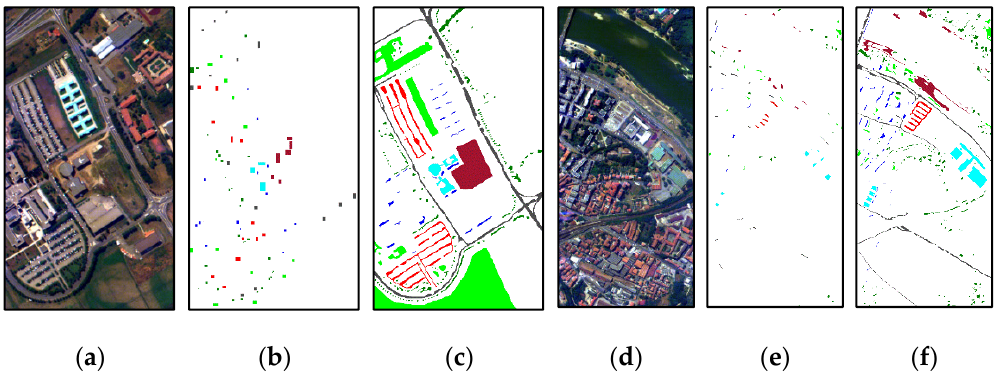
Figure 2. Color composite images of the ( a ) ROSIS Pavia University with the corresponding ground truths: ( b ) train map; ( c ) test map; ( d ) Pavia City Centre with the corresponding ground truths; ( e ) train map and ( f ) test map. Table 1. Class legend for ROSIS University and City Center datasets.